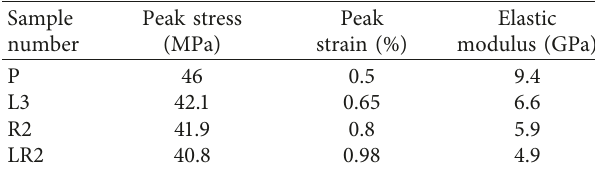
Table 5: The stress-strain test results.